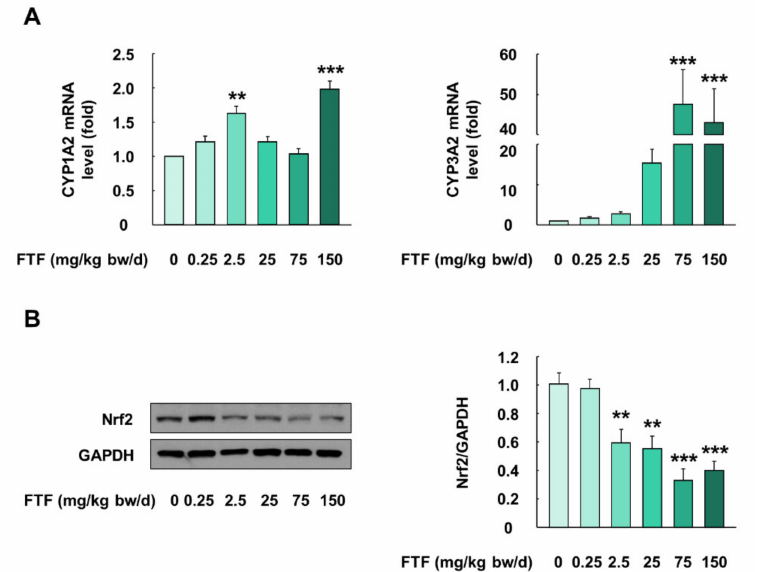
Figure 7. Effects of FTF on gene expression of CYP enzymes and Nrf2 protein expression in female SD rat liver: ( A ) gene expression of CYP1A2 and 3A2 in female SD rat liver; ( B ) protein expression of Nrf2 in female SD rat livers. Rats were administered FTF at 0, 0.25, 2.5, 25, 75, and 150 mg/kg bw/day for 28 days ( n = 3 animals per group). GAPDH was used as the housekeeping protein and gene. Images are representative of three independent experiments. The results are expressed as mean ± SEM and statistically significant differences, as compared to the control (corn oil), are indicated as ** P < 0.01 and *** P < 0.001. Abbreviations: CYP, cytochrome P450; Nrf2, nuclear factor erythroid 2-related factor 2; SD, Sprague Dawley; FTF, flutriafol; GAPDH, glyceraldehyde 3-phosphate dehydrogenase; SEM, standard error of